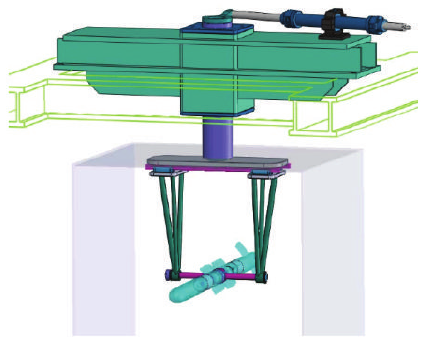
Figure 27: Sketch map of the 3-DOF rig developed by High Speed Aeronautics Institution in CARDC